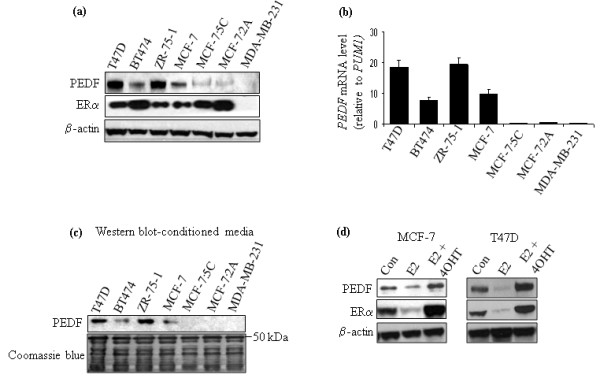
Pigment epithelium-derived factor expression in human breast cancer cell lines. (a) Pigment epithelium-derived factor (PEDF) and estrogen receptor alpha (ERα) protein levels were detected by western blot analysis in several human breast cancer cell lines, including hormone-dependent T47D, MCF-7, and ZR-75-1 cells, tamoxifen-resistant BT474 cells, tamoxifen-resistant and aromatase inhibitor-resistant MCF-7:5C and MCF-7:2A cells, and ER-negative MDA-MB-231 cells. (b) PEDF mRNA expression level in the different breast cancer cell lines was determined by quantitative real-time PCR analysis with PUM1 used as a normalization control. (c) Conditioned media were analyzed by western blot for the presence of PEDF protein in the indicated breast cancer cell lines. Staining of proteins by Coomassie blue included as a loading control. (d) Hormonal regulation of PEDF and ERα protein in MCF-7 and T47D breast cancer cells. Cells were incubated in phenol red-free RPMI media supplemented with 10% charcoal-stripped FBS for 72 hours and, subsequently, were treated with vehicle, 1 nM 17β-estradiol (E2), or 1 nM E2 + 1 μM 4-hydroxytamoxifen (4OHT) for 24 hours, and the PEDF and ERα protein level was determined by western blot analysis. β-actin was used as a normalization control. All experiments were performed in triplicate independently.